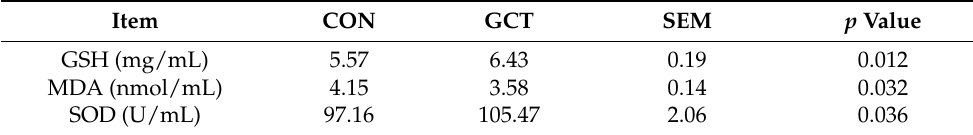
Table 4. Effect of GCT on antioxidant capacity of weaned